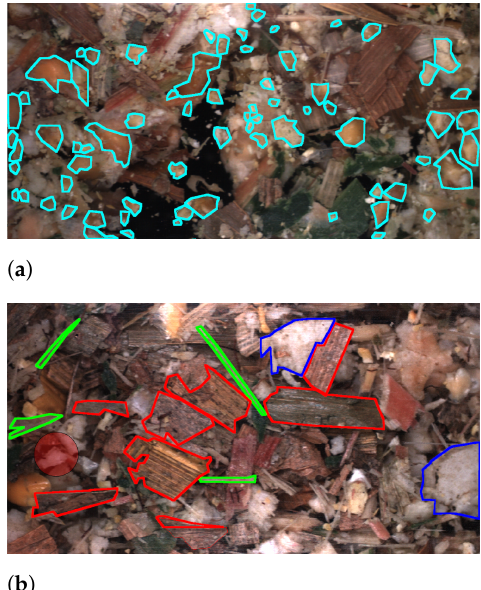
Figure 1. Example annotations of kernel fragments ( a ) and for stover overlengths in ( b